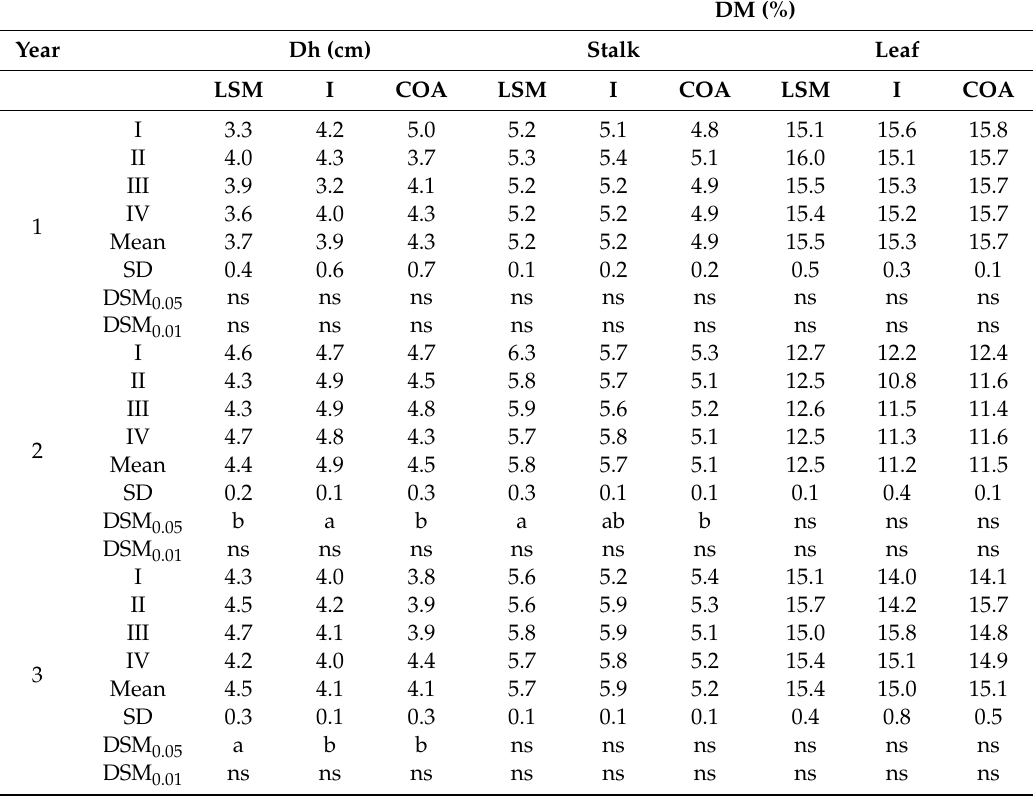
Table 7. The head diameter (Dh) and the dry matter percentage (DM) in the stalk and leaf during three cycles of celery crops grown in the field, as a function of the fertilization treatment: local sheep manure (LSM), mineral (I), and commercial organic amendment